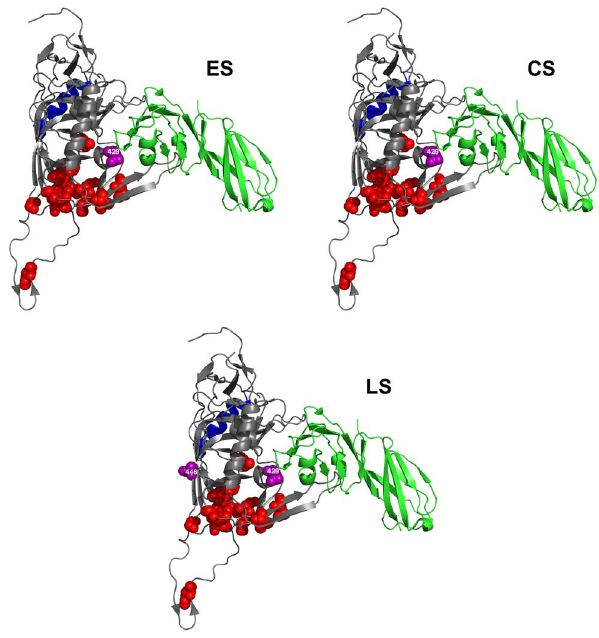
Figure 5. Sites under positive selection pressure in C4 region at different disease stages. HIV-1 gp120 protein model is from JR-FL strain [45]. Sites under selection pressure are indicated as spheres in purple. Labeling of each positively selected site is centered on the a - carbon of the amino acid. CD4 receptor is in green. Residues involved in CCR5 binding are indicated as spheres in red. The a 2 helix region is indicated in blue. Amino acid numbering is according to HXB2 sequence. ES = Early disease Stage CS = Chronic disease Stage LS = Late disease Stage.